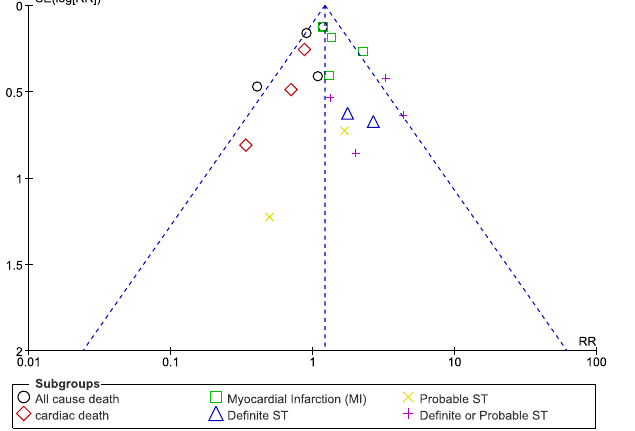
Figure 16. Funnel plot representing publication bias ( B ).